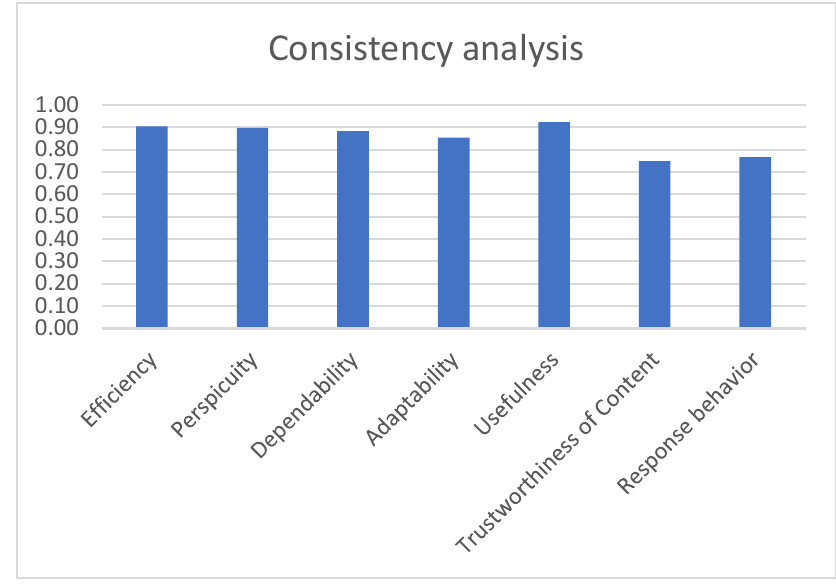
Figure 14. Consistency